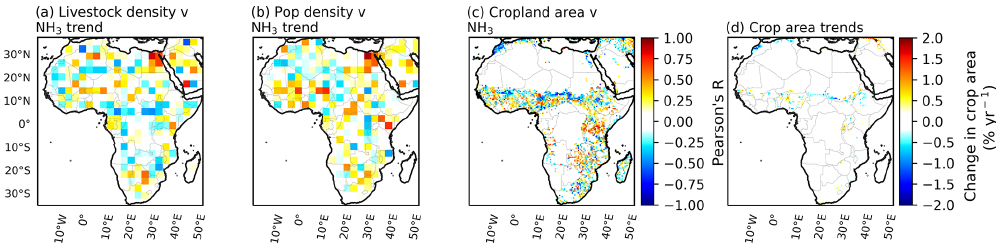
Figure 2. Relationships between NH 3 trends and livestock density, population density, and cropland area as well as changes in cropland area. Spatial correlations between changes in annual atmospheric NH 3 VCDs and livestock density (a) and population density (b) . Correlation between cropland area and NH 3 VCDs for 2008 through 2018 (c) . Change in crop area for 2008 through 2018 (d) . The NH 3 and crop area trends are based on data for 2008 through 2018, livestock density data are for the year 2007, and population density data are for the year